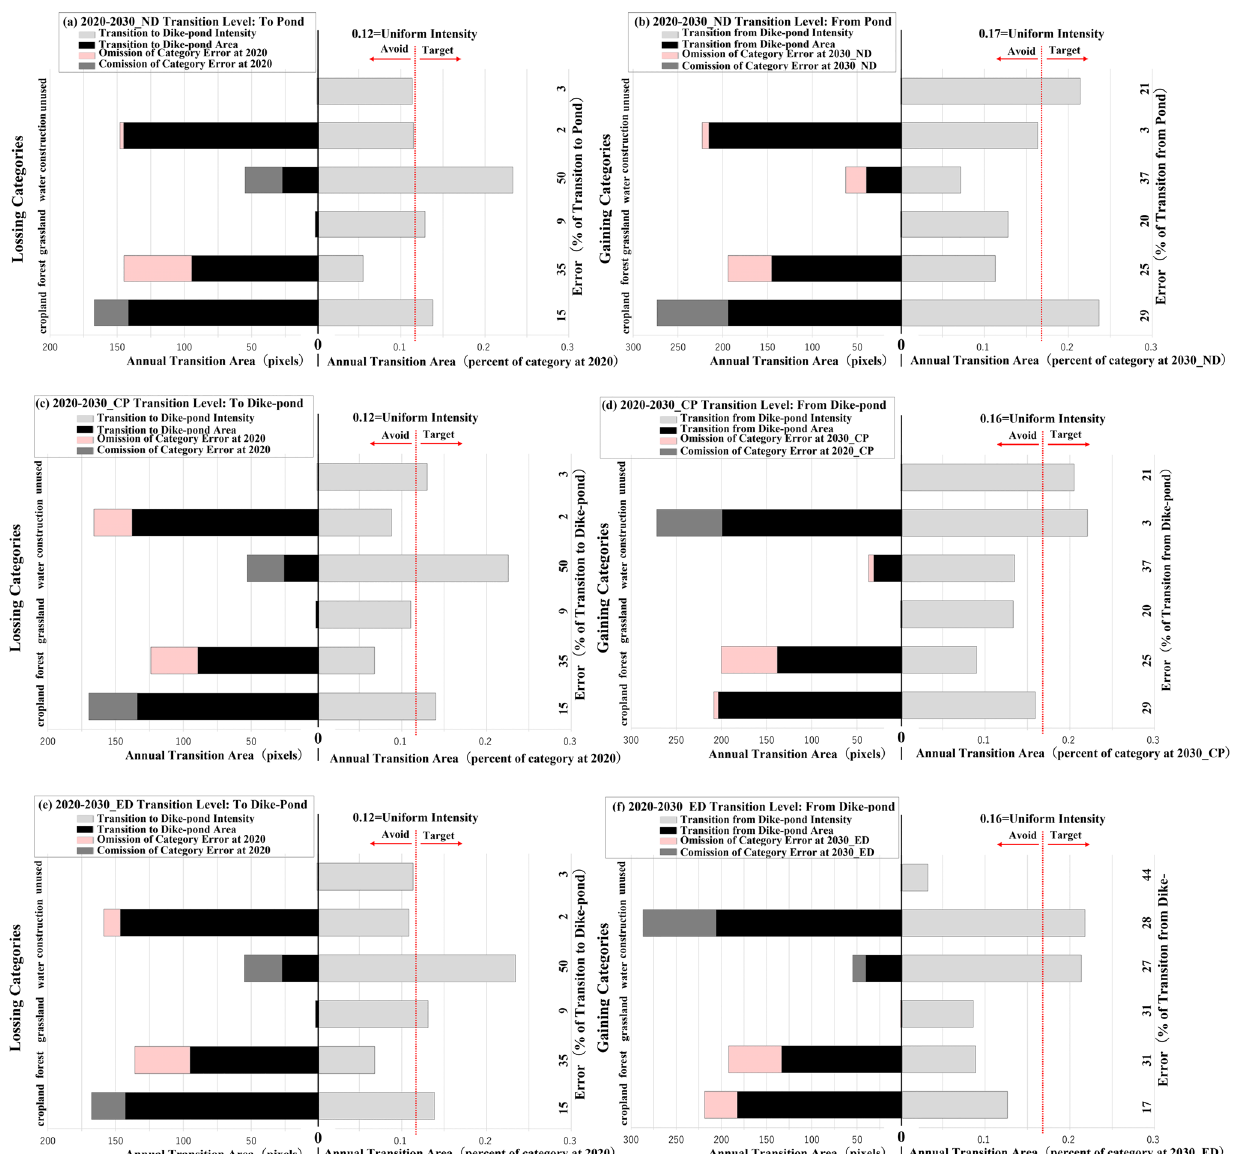
Fig.14 Transition level of the dike-pond at three simulated scenarios from 2020 to